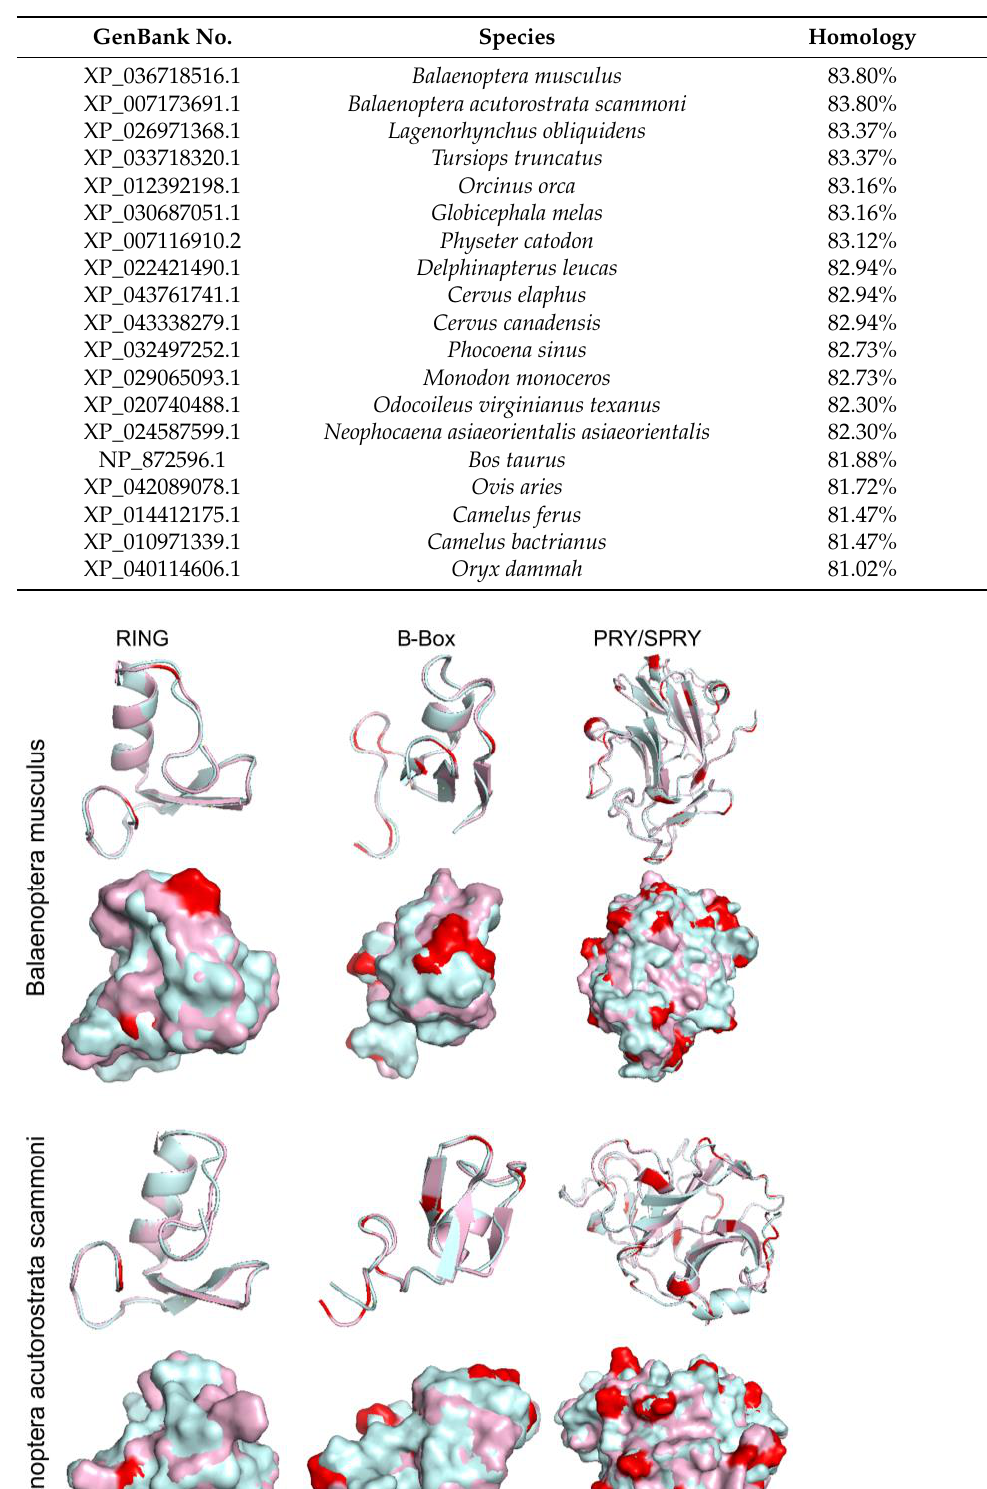
Table 1. The homology between porcine TRIM21 and TRIM21 of 19 species.